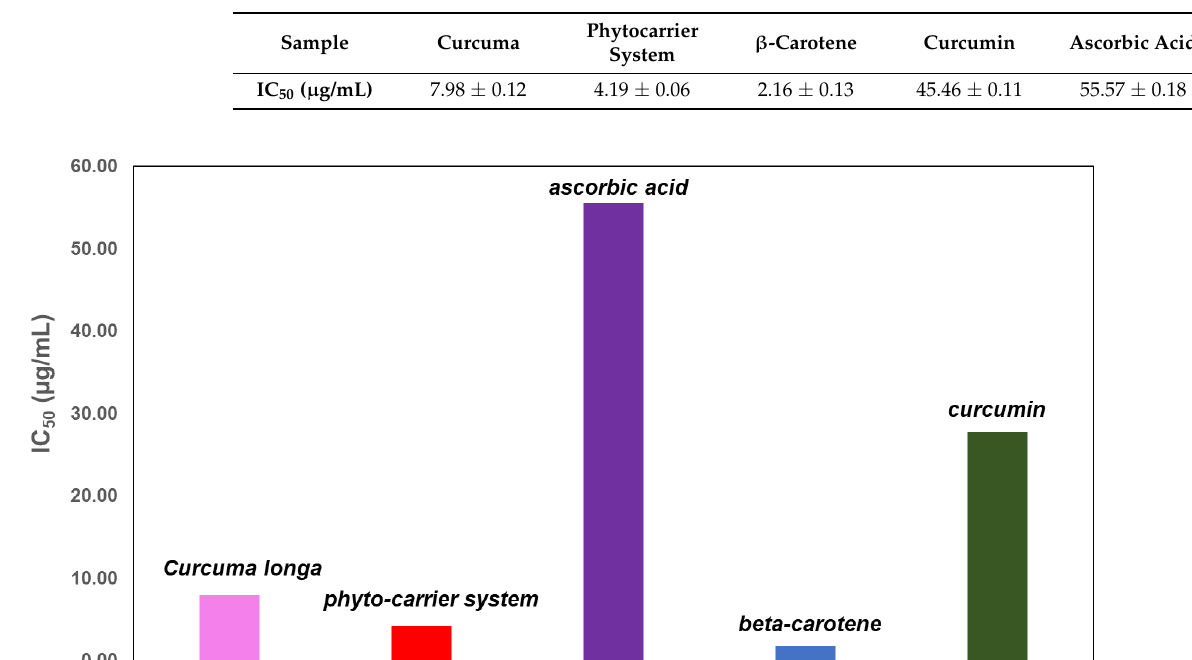
Table 5. IC 50 values for curcuma, the phytocarrier system and standard antioxidants (ascorbic acid, curcumin and beta-carotene).